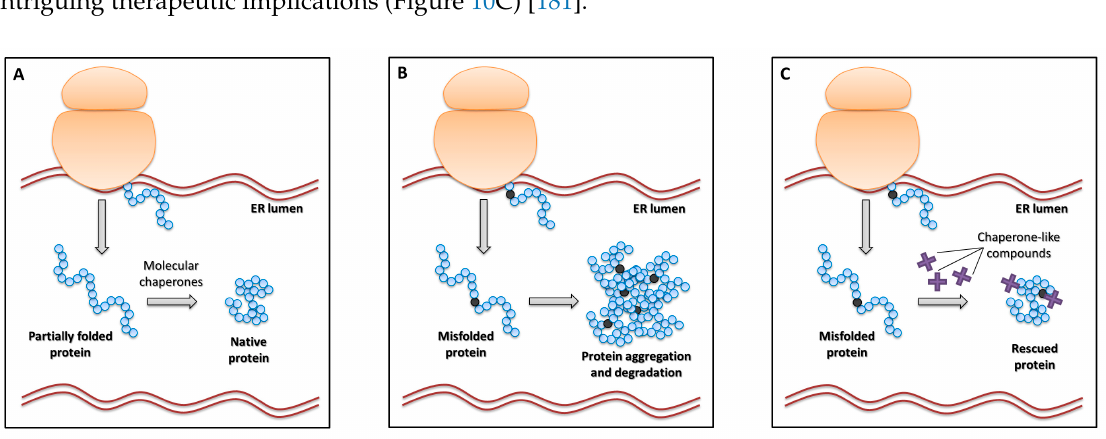
Figure 10. Impact of missense changes on protein folding and correction approaches through chaperone-like compounds. ( A ) Protein folding in normal conditions assisted by molecular chaperones, with a final production of the native protein conformation. ( B ) Aberrant folding and the consequent aggregation / degradation of misfolded proteins, unable to reach the native conformation, due to amino acid substitutions caused by missense changes. ( C ) Rescue of folding of misfolded proteins mediated by chaperone-like compounds.